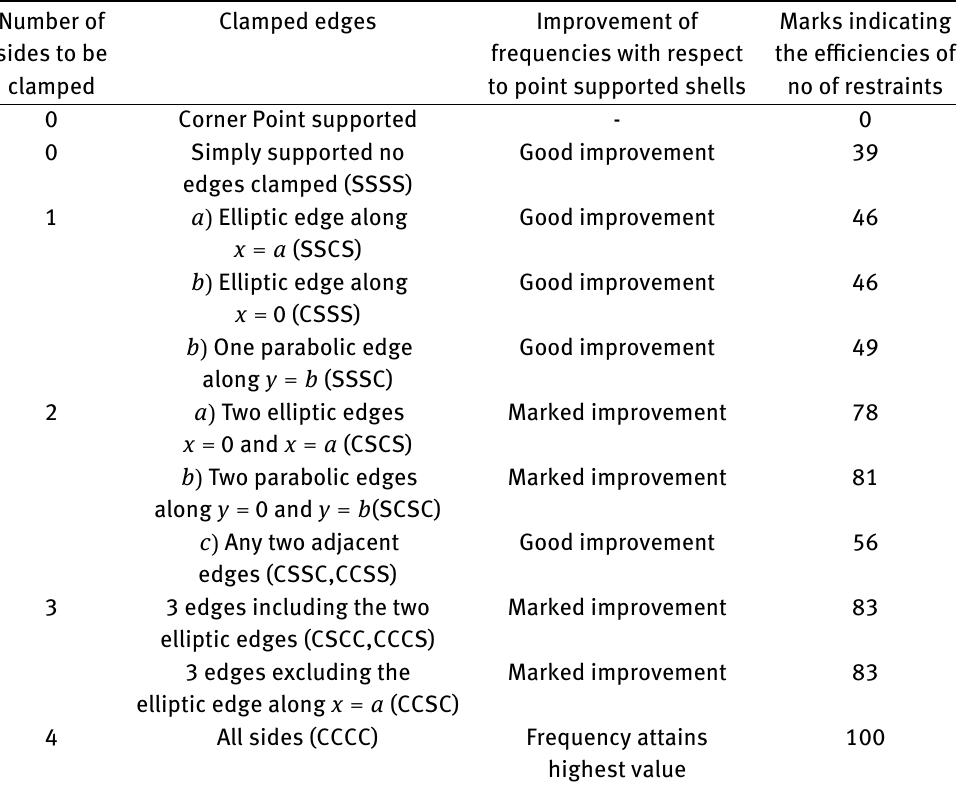
Table 5: Clamping options for 0/90/0/90 elliptic parabolic shells with central cutouts having a / / a ratio 0.2. Number of Clamped edges Improvement of Marks indicating sides to be frequencies with respect the eflciencies of